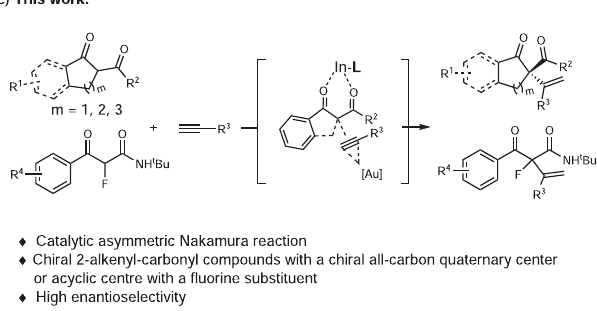
Fig. 1 The catalytic asymmetric addition of 1,3-dicarbonyl compounds to alkynes. a Catalytic asymmetric Conia-ene reaction. b Development of Nakamura reaction. c Our strategies for the catalytic asymmetric Nakamura